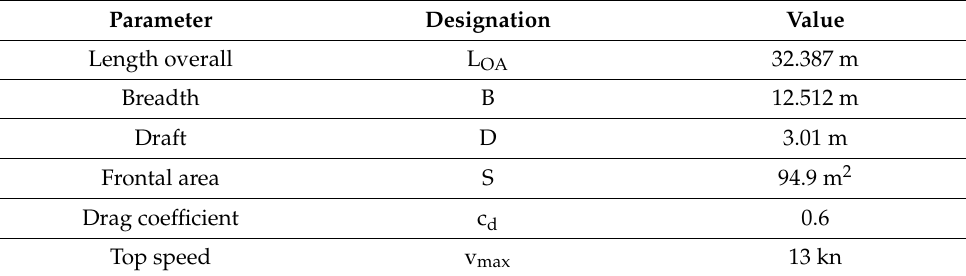
Table 2. Parameters of tugboats included in the formation.